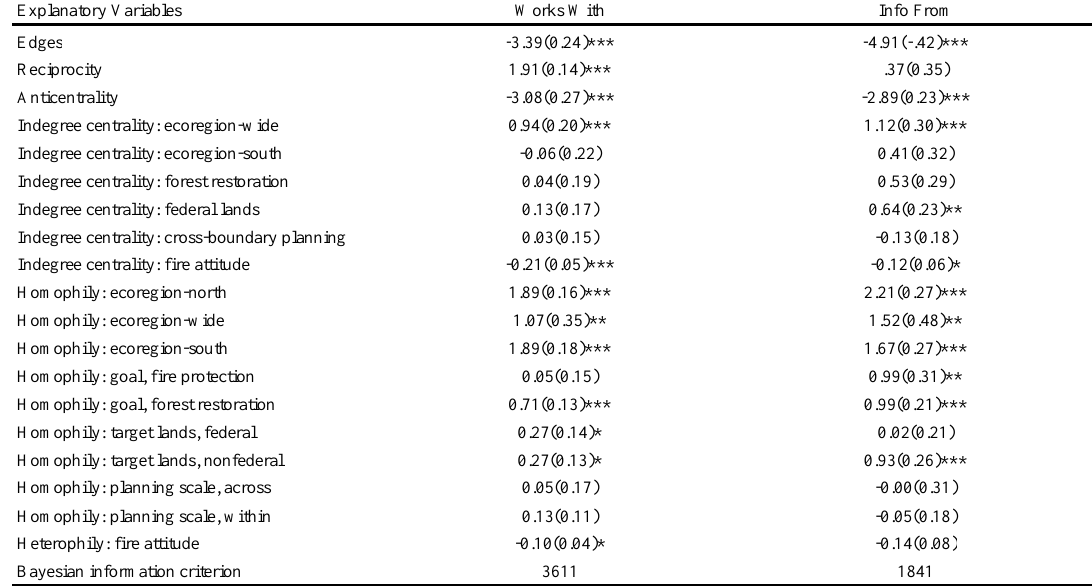
Table 2 . Results of the exponential random graph model of the likelihood of an organization naming another